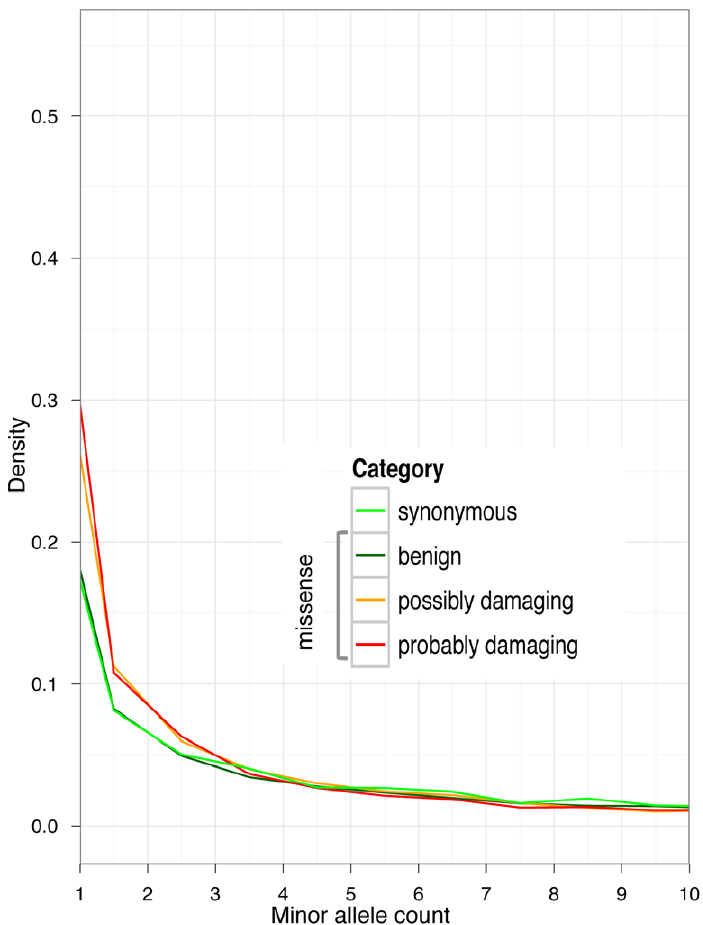
Figure 4. Allele frequency spectra in GoNL data, for synonymous alleles and non-synonymous alleles stratified by PolyPhen-2 functional predictions. For better presentation, the graphs have been cropped at minor allele count 10.